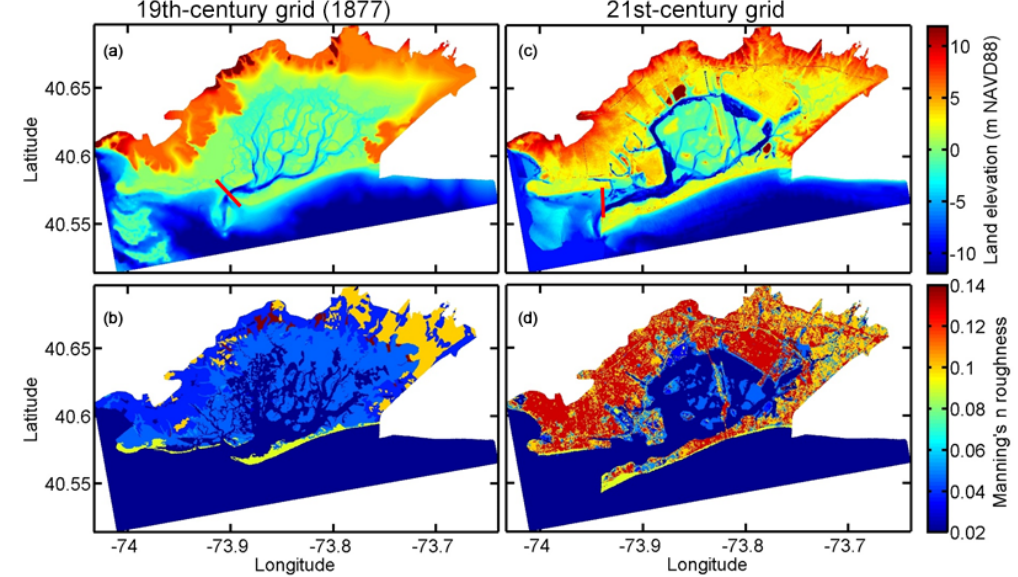
Figure 5. 1870s and early 21st-century landscape data used as inputs to the hydrodynamic model. Panels (a, c) are land elevation maps, and (b, d) are land cover roughness (Manning’s n) maps. Panels (a, b) show the 1870s and (c, d) show the present-day landscape. Red lines delineate the inlet boundary for defining the interior of the bay and tidal prism. Table 1. Estuarine habitat types and their area for the 1870s and present